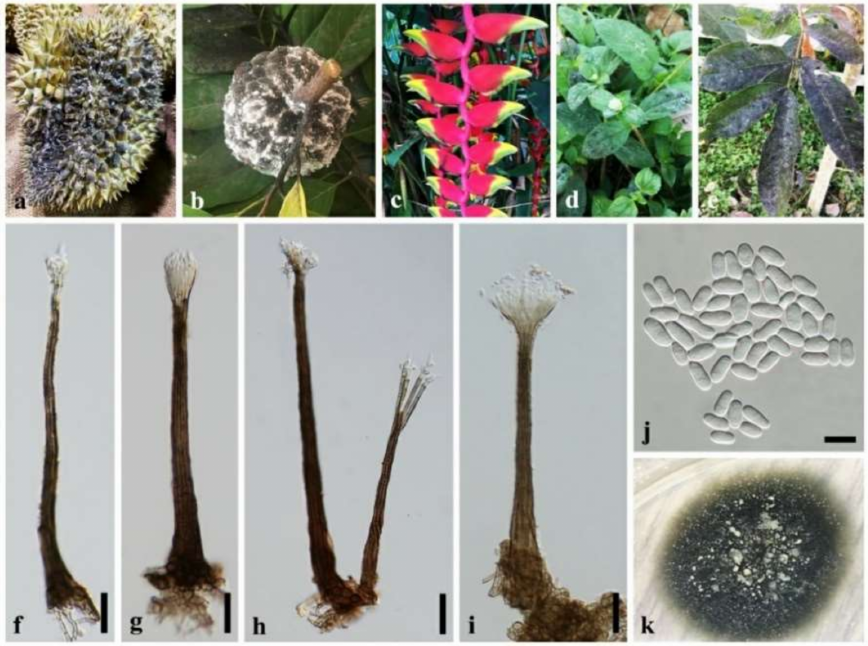
Figure 4. Leptoxyphium spp. ( a – e ) host plants: ( a ) Durio ziberhinus (CRC 98), ( b ) Annona squamosal (CRC 101), ( c ) Strelitzia reginae (CRC 102), ( d ) Gomphrena globose (CRC 108), ( e ) Lagerstroemia speciose (CRC 110); ( f – i ) conidiomata, ( j ) conidia, ( k ) colony on PDA. Scale bars: ( f – i ) = 50 µ m; ( j ) = 10 µ m.